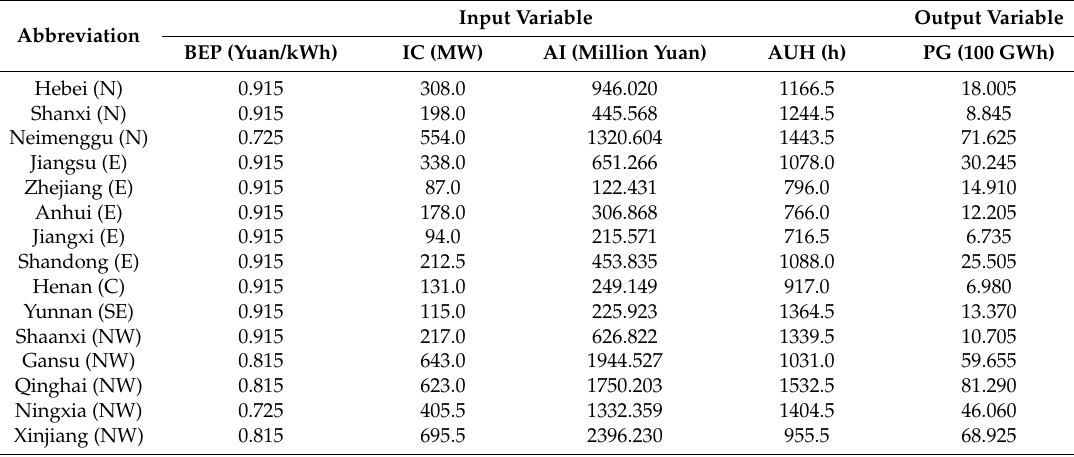
Table 1. Mean of efficiency analysis indicators.